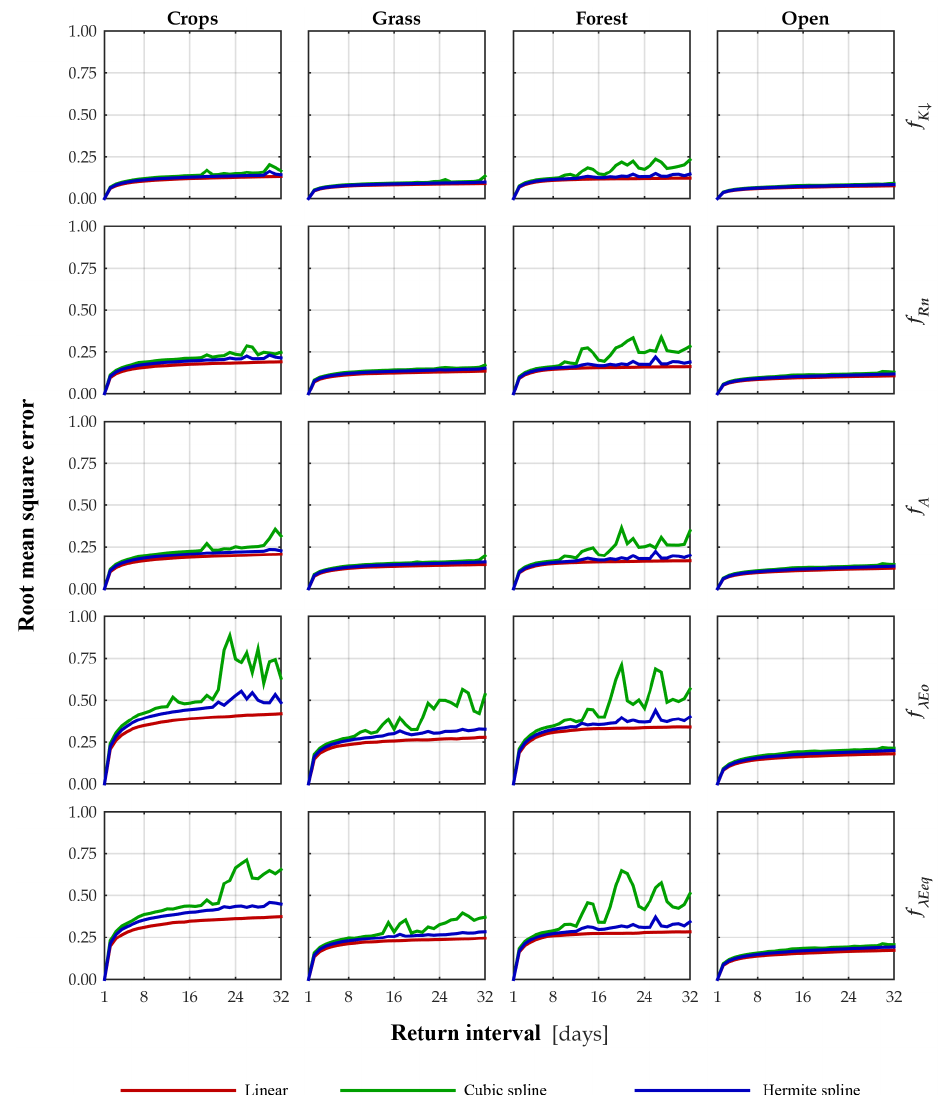
Figure 5. The root mean square error (RMSE) of the estimates of the scaled quantities is shown for each land cover type and interpolation